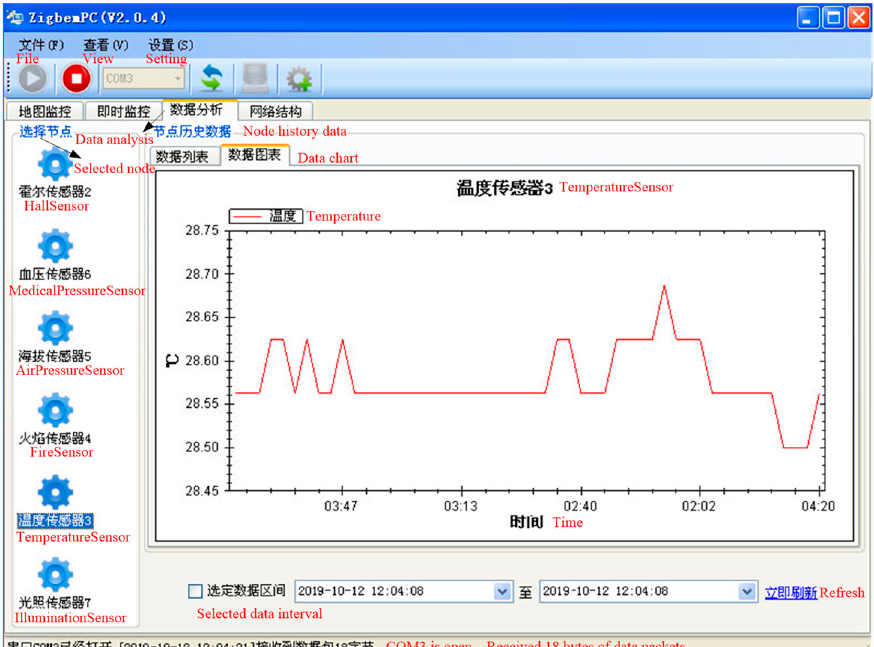
Figure 8. The data chart for node 3.